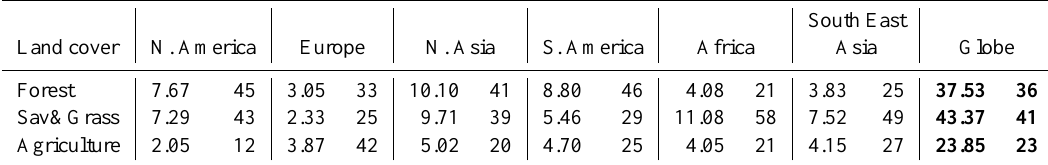
Table 4. Spatial distribution [10 6 km 2 ] and proportion [%] of the area covered by each class for the continental windows and for the globe.